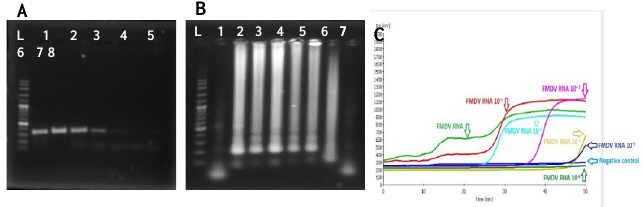
primer. With typing primer, RT-LAMP successfully typed 03 out of 05 (60%),06 out of 12 (50%) and 01 out of 01 (50 %) samples positive for